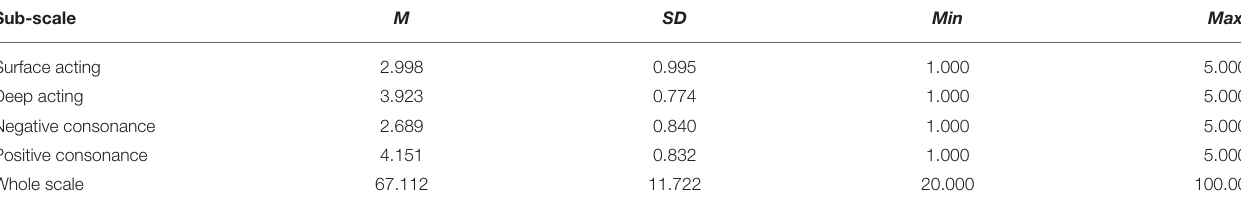
TABLE 6 | Descriptive statistics of the Beginning EFL Teachers’ Emotional Labor Strategy Scale ( N = 325).